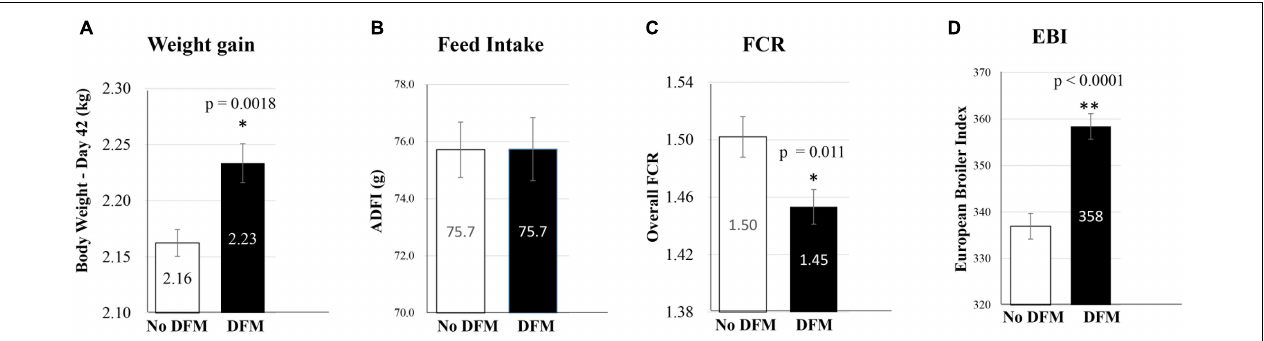
FIGURE 6 | Effect of in-feed administration of Ba PTA-84 on growth performance of broiler chicken. Growth performance as measured by four parameters, (A) weight gain, (B) feed intake, (C) Feed Conversion Ratio (FCR), and (D) European Broiler Index (EBI).